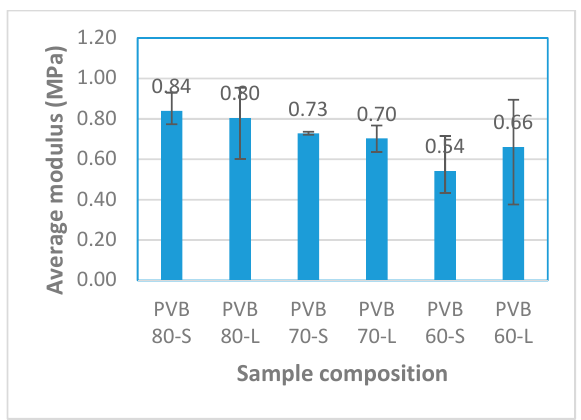
Figure 4. Average modulus of elasticity of the composite samples. S, short cut; L, long cut.